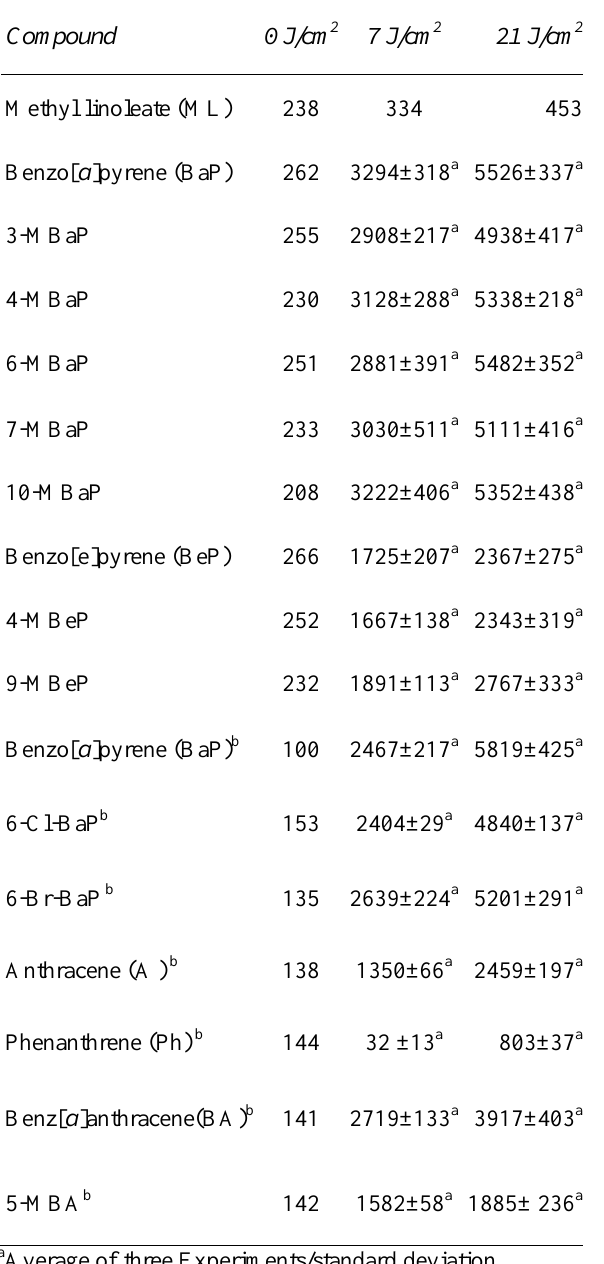
Table 1: Induction lipid peroxidation by benzo[a]pyrene, benzo[e]pyrene and their methylated derivatives with concomitant exposure to UVA light irradiation a